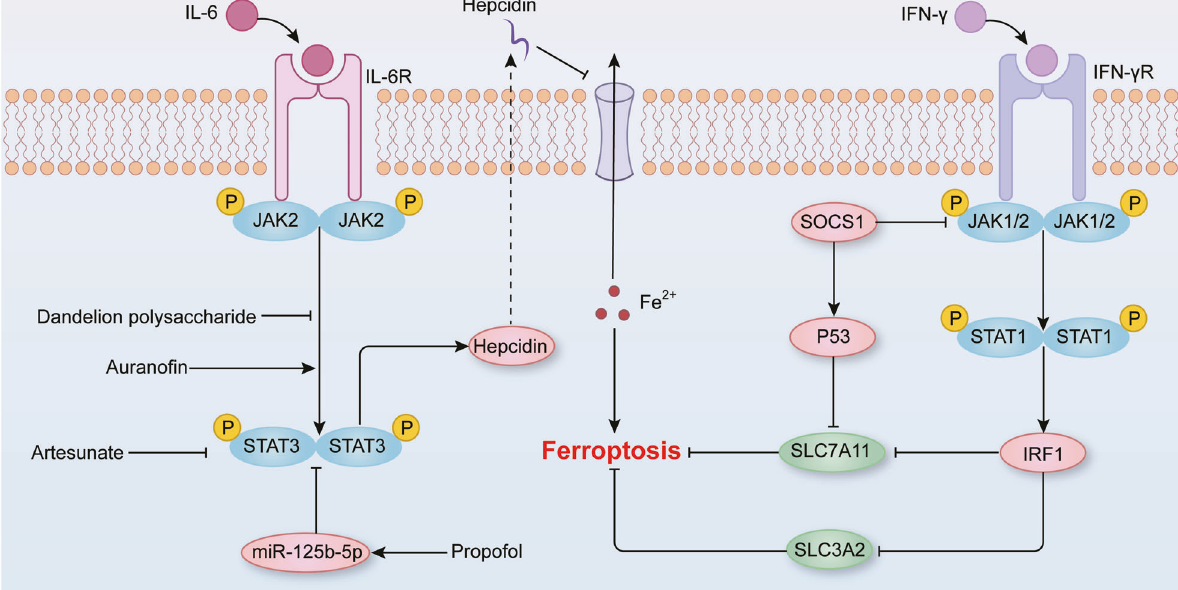
Fig. 3 The role of JAK-STAT signaling pathway in ferroptosis. Cytokines, such as IL-6 and TNF bind to their corresponding receptors and thus induce the phosphorylation and activation of JAKs. In turn, activated JAKs phosphorylate STATs and induce their dimerization and nuclear translocation. Finally, STAT dimers bind to DNA sequences to induce the transcription of target genes and the activation of downstream signaling pathways. As a downstream target of the JAK-STAT pathway, phosphorylated STAT3 can increase hepcidin expression to inhibit iron export, resulting in ferroptosis. Moreover, activated STAT1 inhibits System Xc - and exerts proferroptosis effects by via modulating IRF1. Cell Death and Disease (2023)